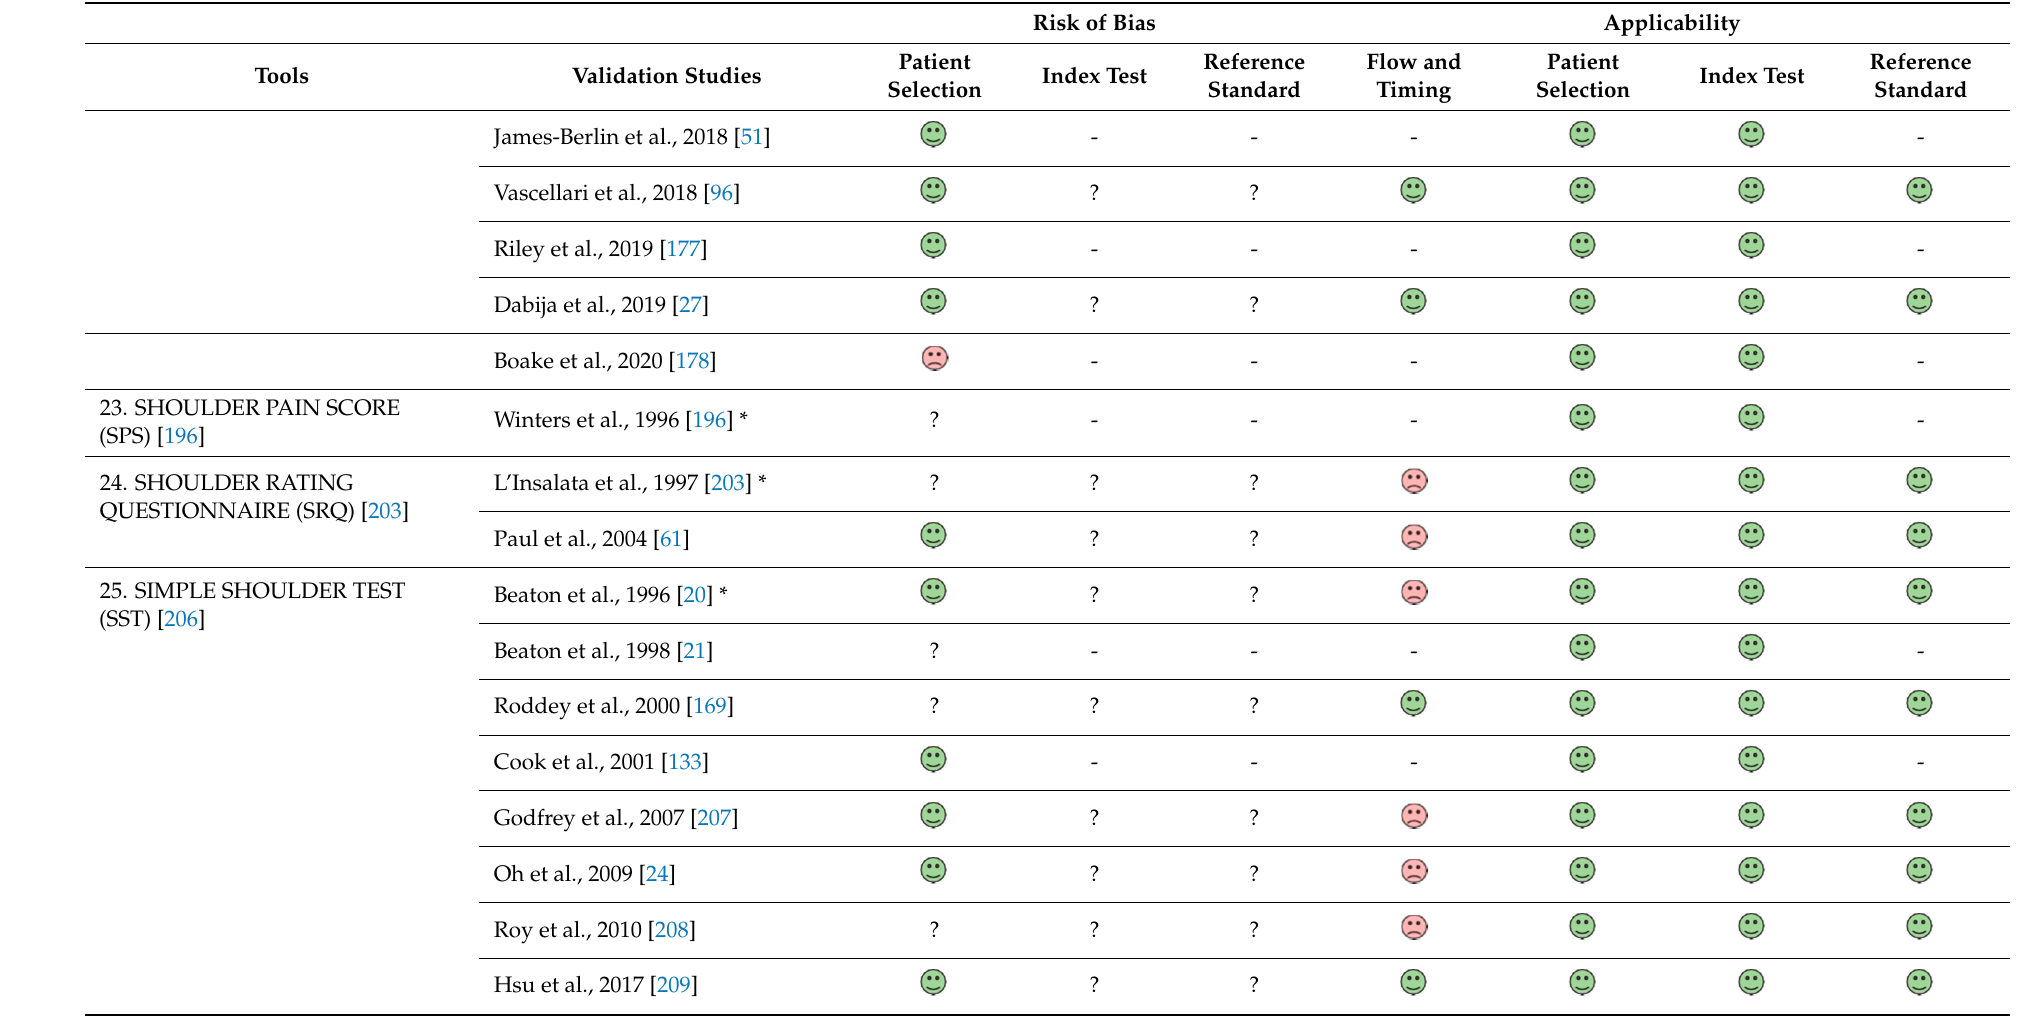
Table 3. Assessment of the methodological quality with QUADAS ‐ 2.